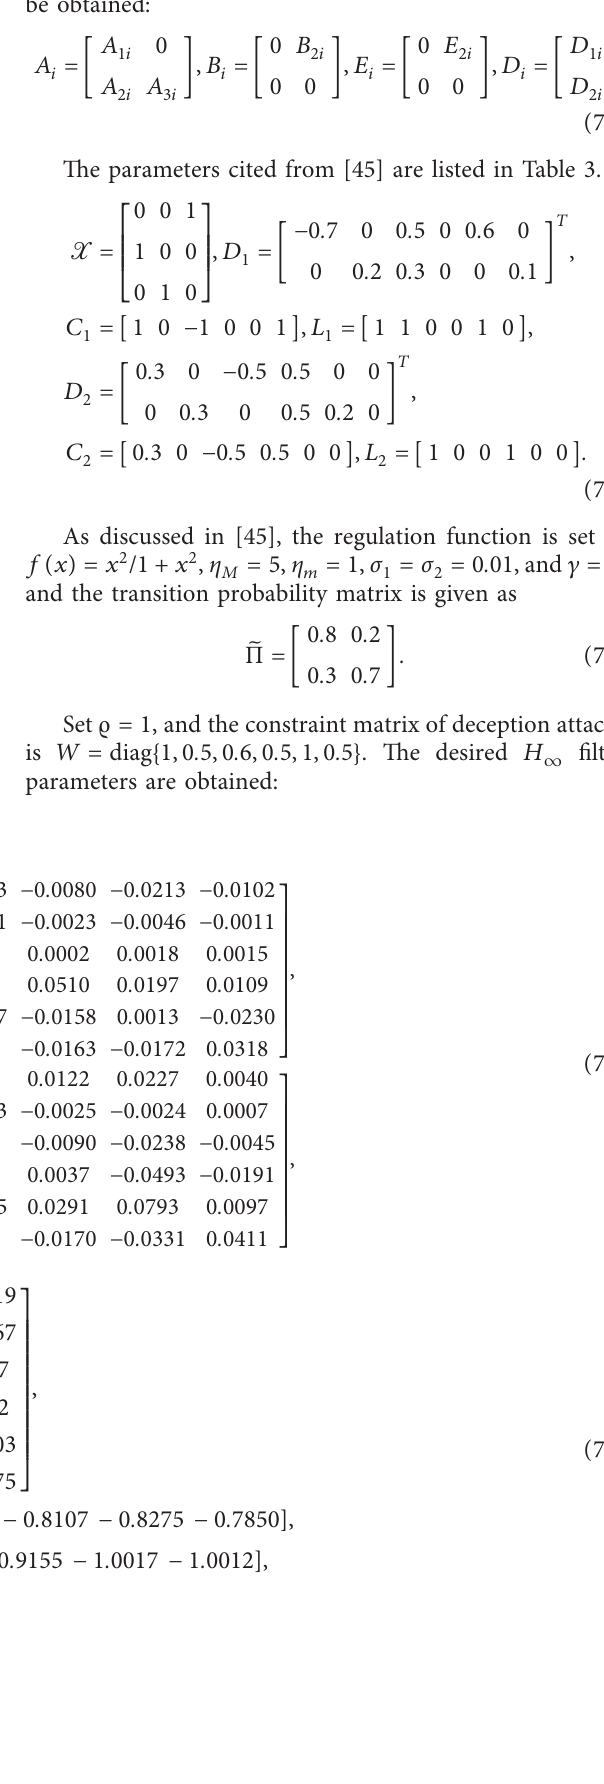
Table 2: The transmission rates and c